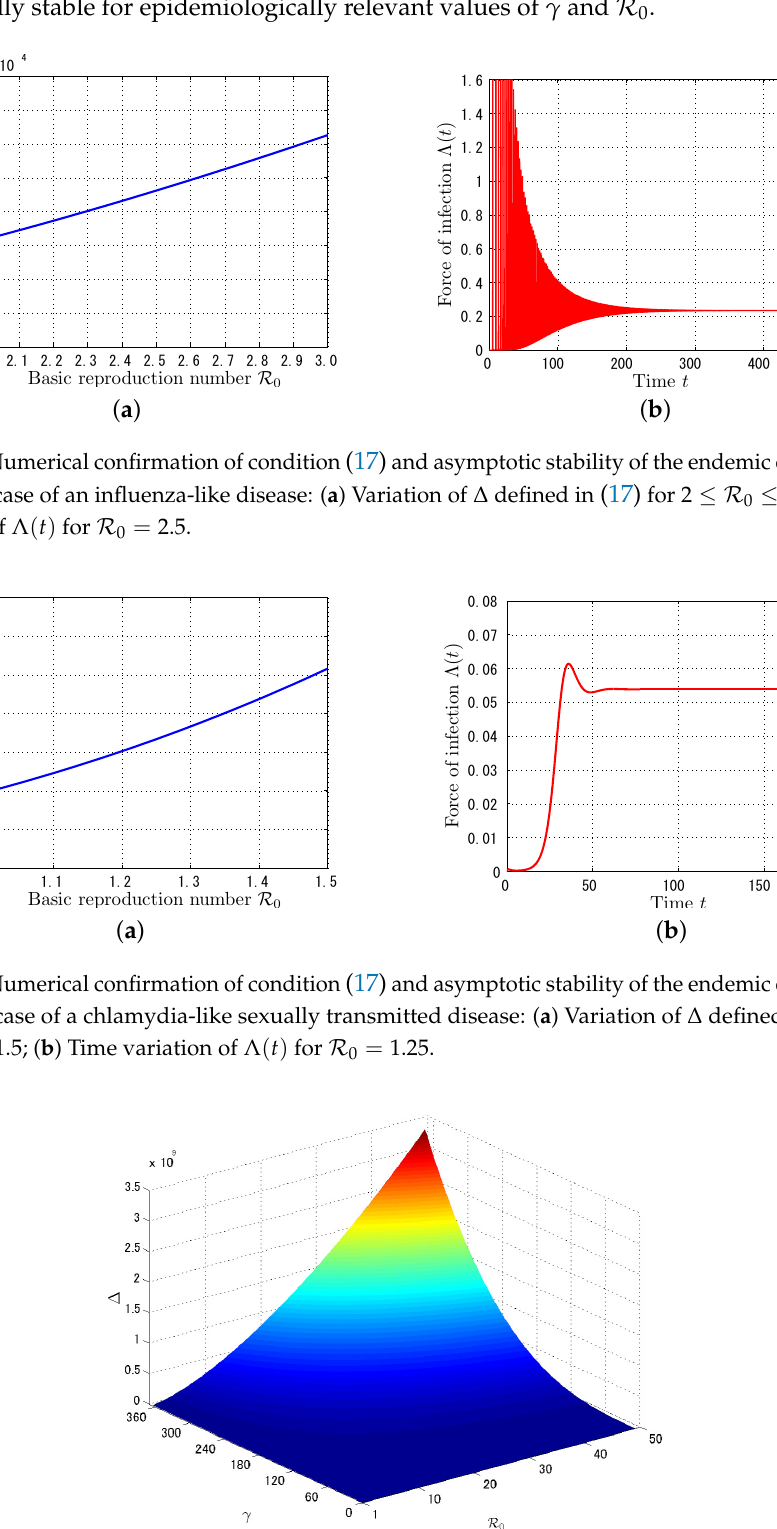
Figure 3. Numerical confirmation of condition (17) for realistic values of recovery rate γ and the basic reproduction number